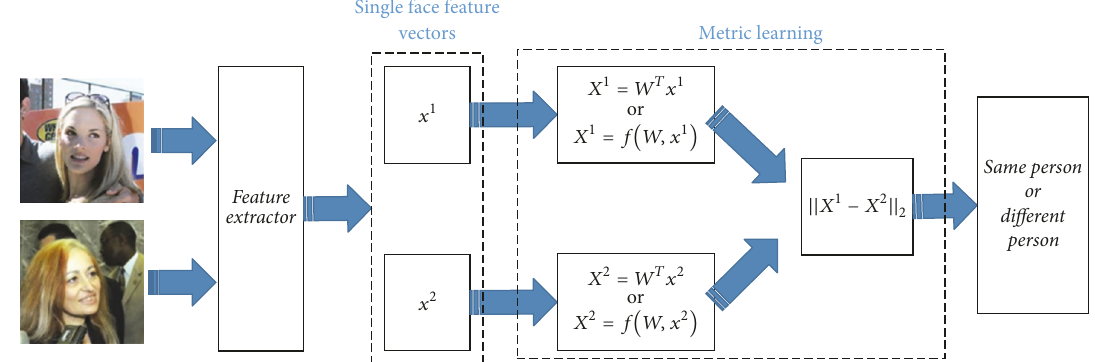
Figure 2: The overall framework of face verification based on conventional Mahalanobis distance